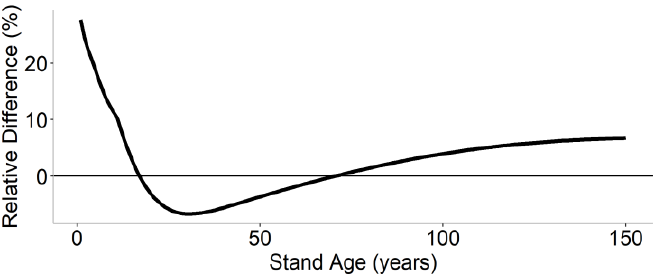
Figure 12. Relative difference ((CBM-PSP)/PSP ∗ 100) in carbon estimation between PSP and CBM computation methods when aggregated to the landscape level, with even levels of forest communities in a 150-ha forest simulated over 150 years.